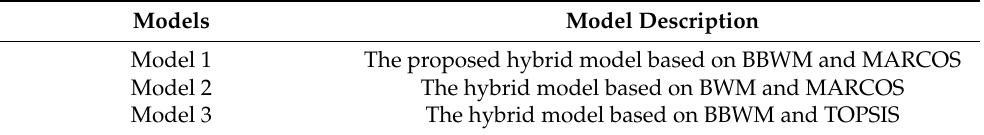
Table 8. The models for ranking similarity comparison.